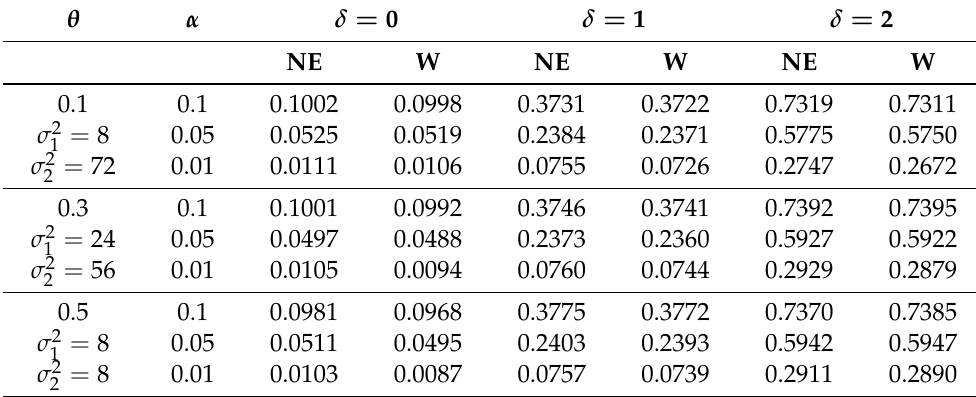
Table 3. Power values for ( n 1 , n 2 ) = ( 8,8 ) .